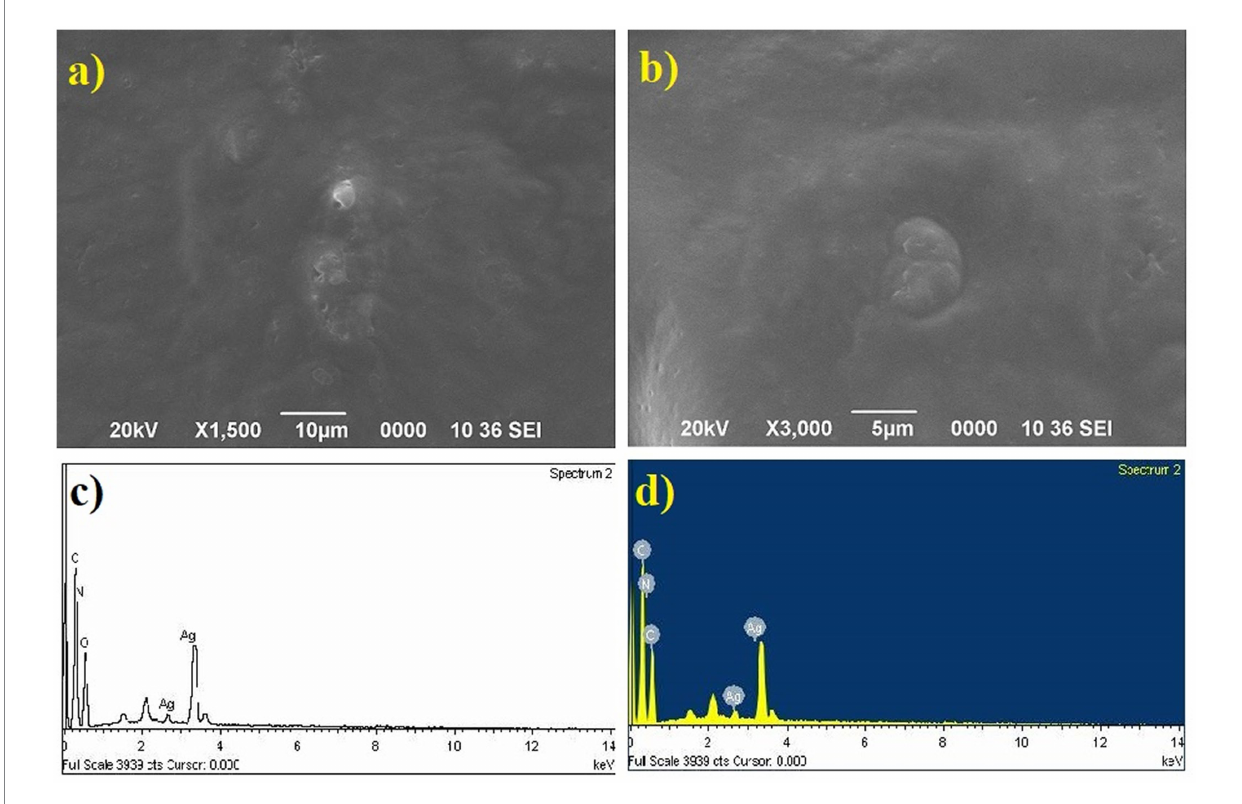
FIGURE 8 SEM image of Ag loaded compound and the EDX spectrum.